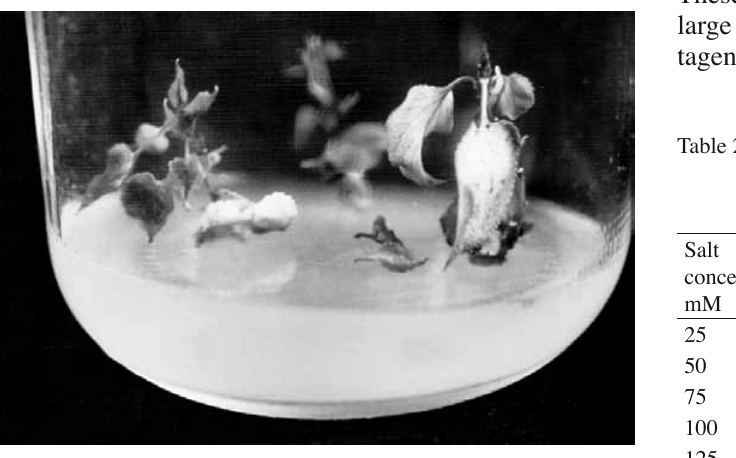
Fig. 2 - Effect of gamma irradiation 100 Gy, six weeks after the treat - ment on in vitro apricot